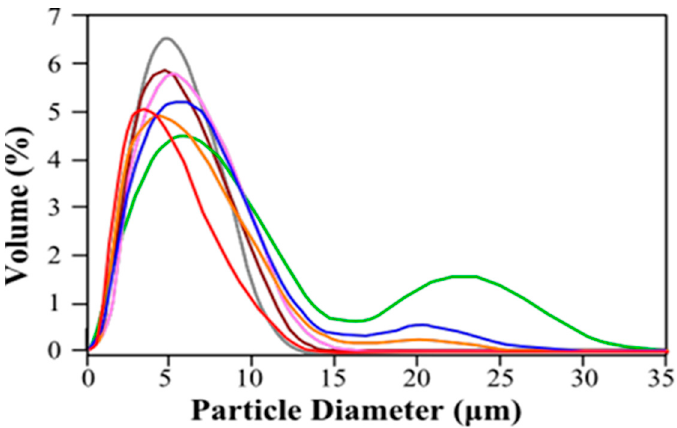
Figure 2. Examples of particle size measurement by light scattering. Red line; control (non-loaded microcapsules), Brown, Grey, Orange, Pink, Blue and Green lines; loaded microcapsules (A3, A6, A7, A10, A12 and A13, respectively).